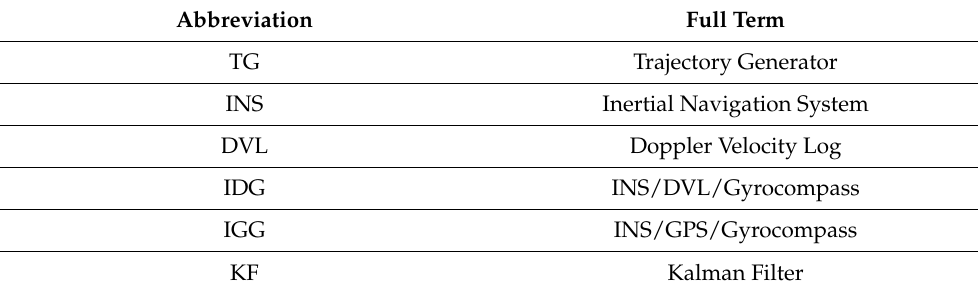
Table 1. Abbreviations and full